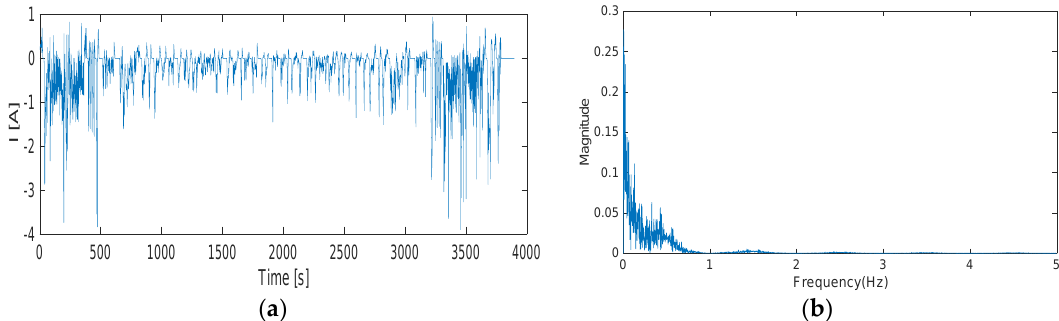
Figure 13. Federal driving schedule (FDS) profile ( a ), Fourier transform of FDS ( b ).